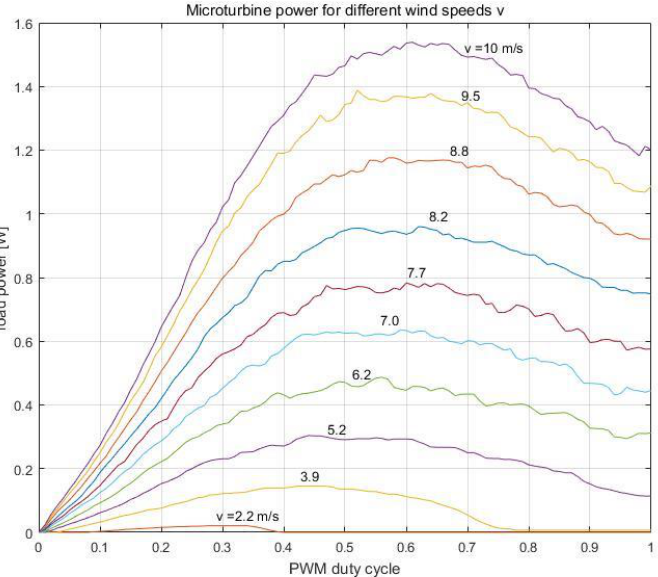
Figure 10. The power generated by a wind turbine for a linear load as a function of the control value — the duty cycle of the PWM signal, for different wind speeds.